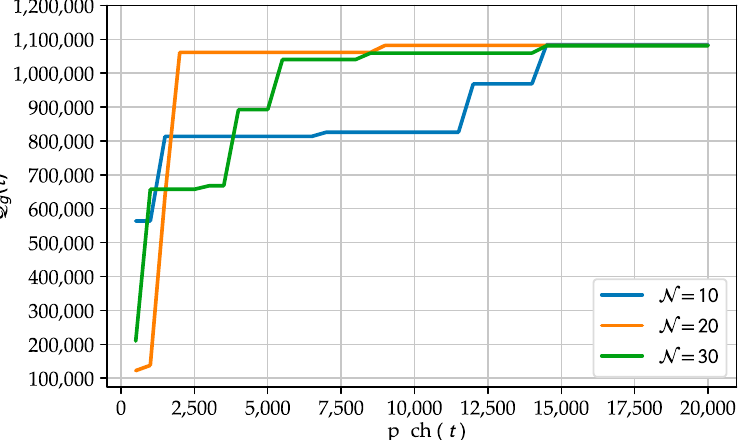
Figure 3. The best particles’ quality (cid:81) g ( t ) observed at each epoch t for some number of particles. It was observed that when (cid:78) = 20, the convergence of PSO was faster. Moreover, no improvement was observed after t > 10,000 epochs for (cid:78) =